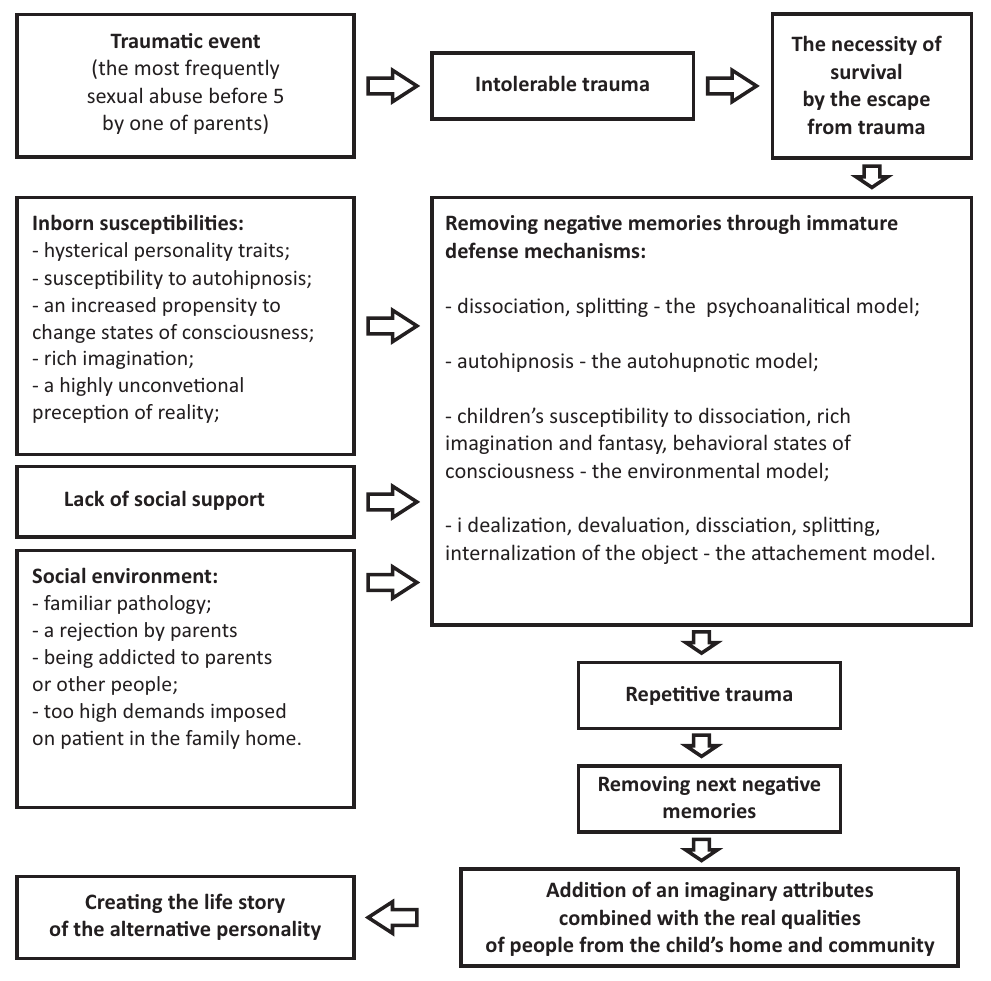
Figure 1. DID as a wide range of defense mechanisms against childhood